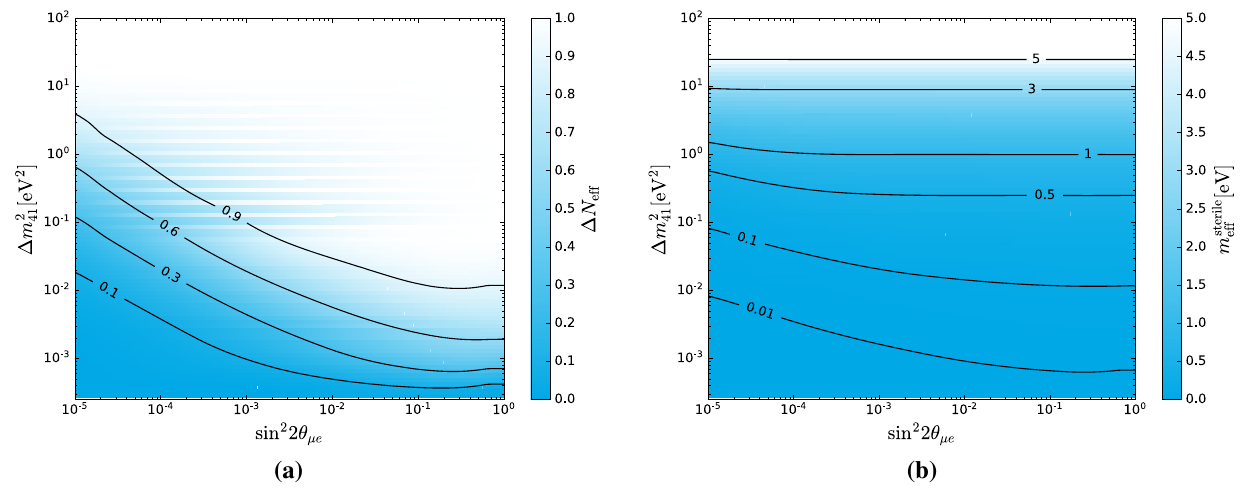
Fig. 3 The cosmological parameters a (cid:3) N eff and b m sterile momentum approximation as described in the text